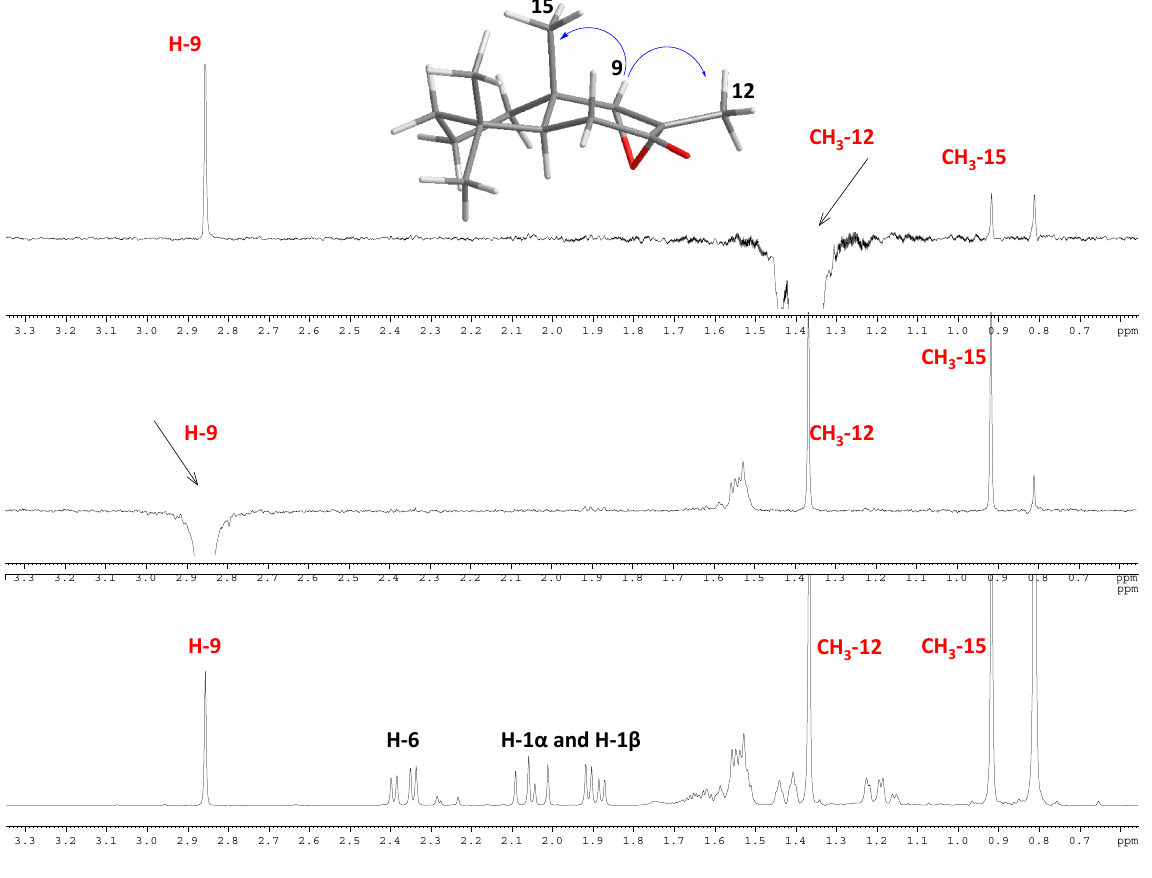
Figure 2. Bottom: 1 H-NMR spectrum of compound 12 . Top: 1D 1 H NOESY experiment ( selnogp pulse program from Bruker Library) showing the main long-range interactions between CH 3 -12 and H-9, H-9 and CH 3 -15.